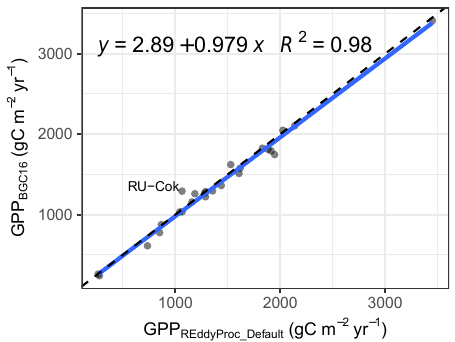
Figure 7. Prediction of annually aggregated GPP from REddyProc daytime partitioning agree with BGC16 across